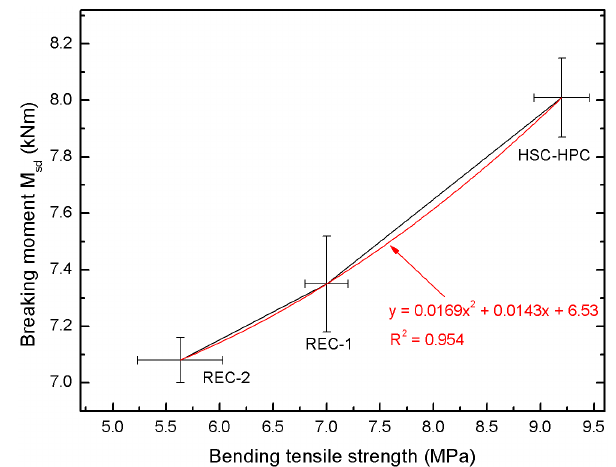
Figure 6. Correlation between bending tensile strength and breaking moment M sd of analyzed concrete.